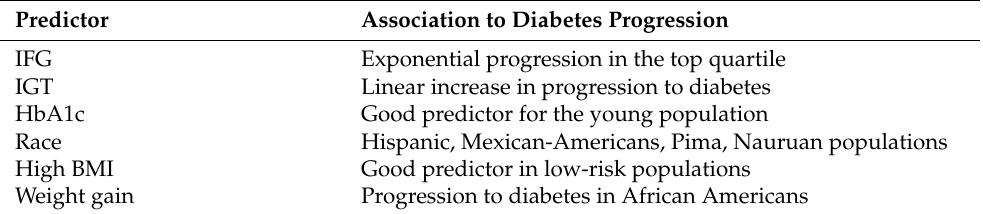
Table 3. Predictors of progression to diabetes